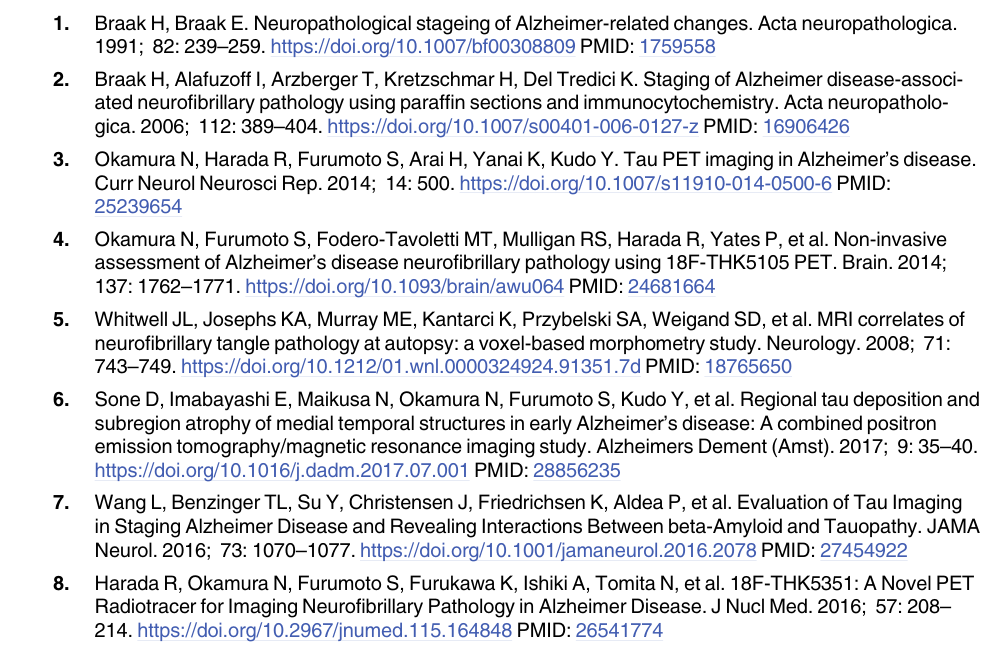
S2 Table. Locations exhibiting significant group-wise difference between THK-5351 uptake and cortical atrophy with age